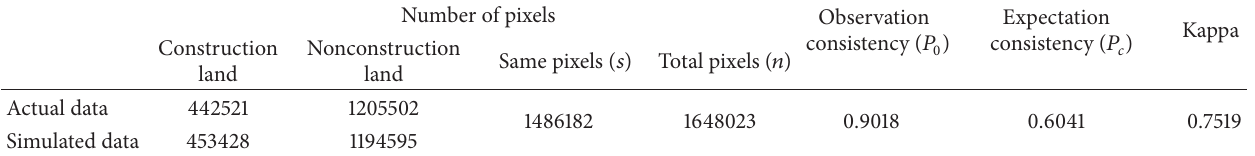
Table 7: Kappa coefficient of construction land.